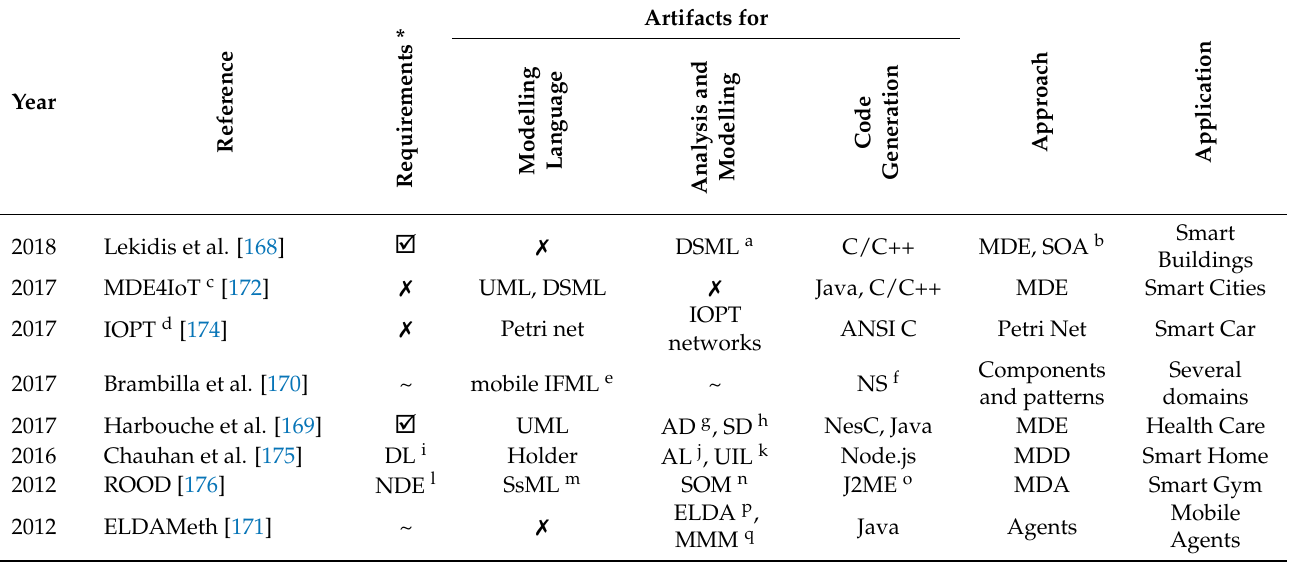
Table 2. Methodologies focused on IoTS development, and the artifacts used and/or recommended to achieve their objectives. Table 3. Methodologies specifying the stages of the life cycle.